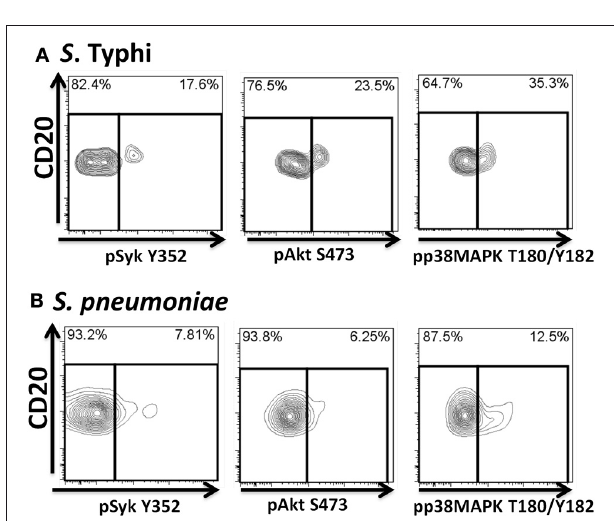
FIGURE 10 | Bacteria-induced cell signaling in Um B cells. B cells interacting with fluorescently labeled bacteria were assayed for phosphorylation of signaling proteins (Syk, Akt, and p38MAPK). Shown are phosphorylation patterns in Um B cells from a representative volunteer following stimulation with S . Typhi (A) or S. pneumoniae (B) at the 10min time